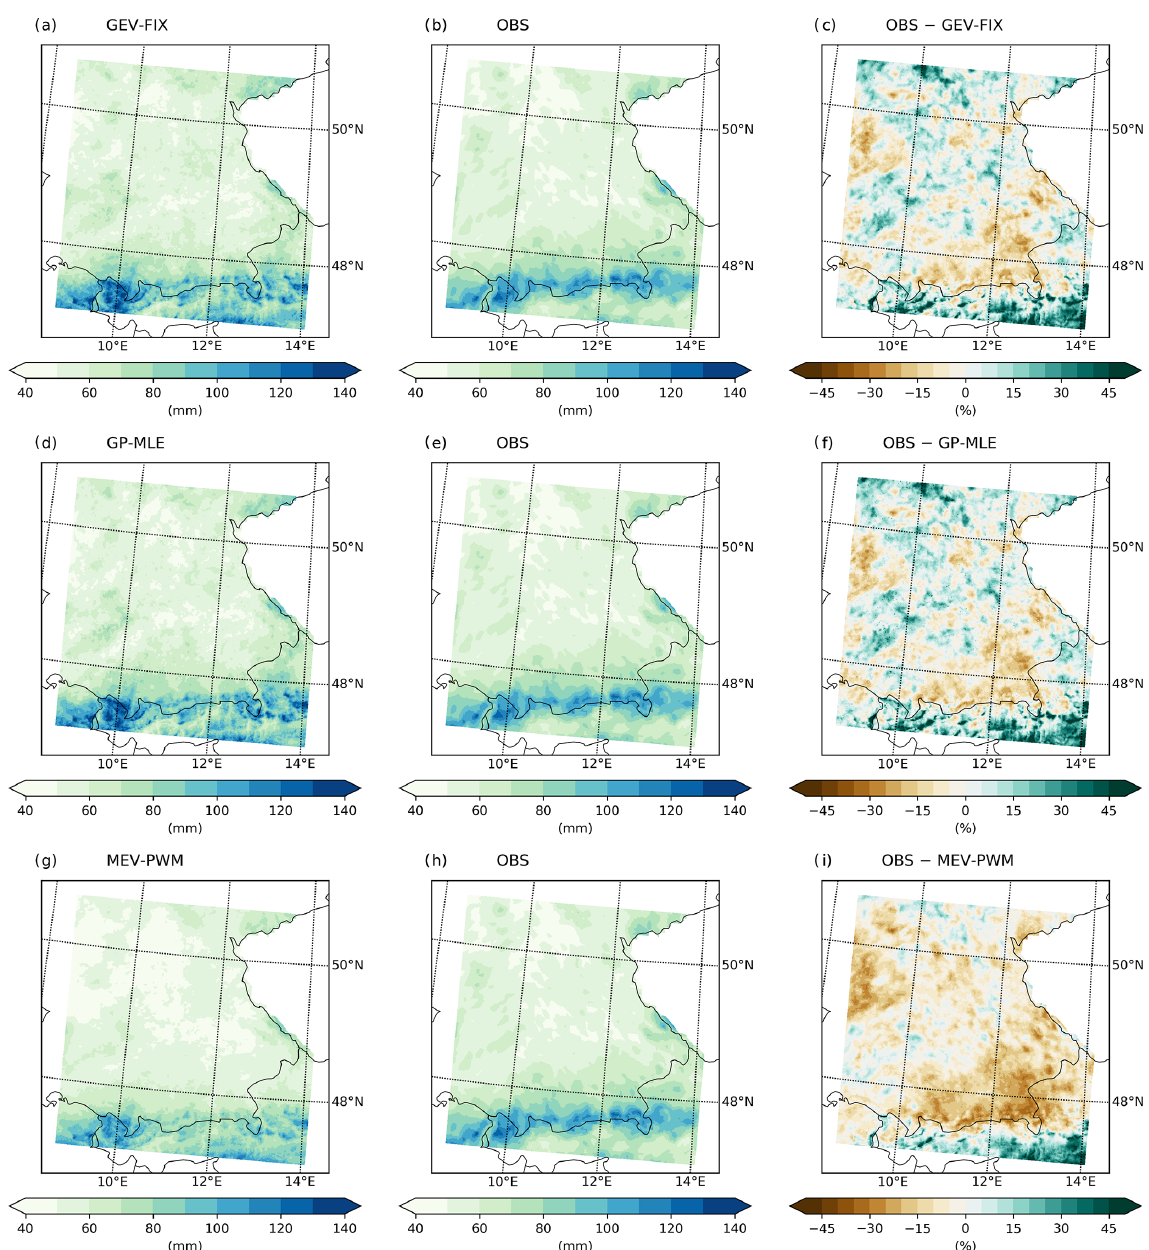
Figure 6. The 10-year rainfall return levels based on WRF ERA5 featuring GEV-FIX (a) , GP-MLE (d) , and MEV-PWM (g) . The middle column (b, e, h) shows the observational product interpolated to the WRF-ERA5 grid. The right column (c, f, i) provides the percentage difference calculated as the climate model return level minus the observational return